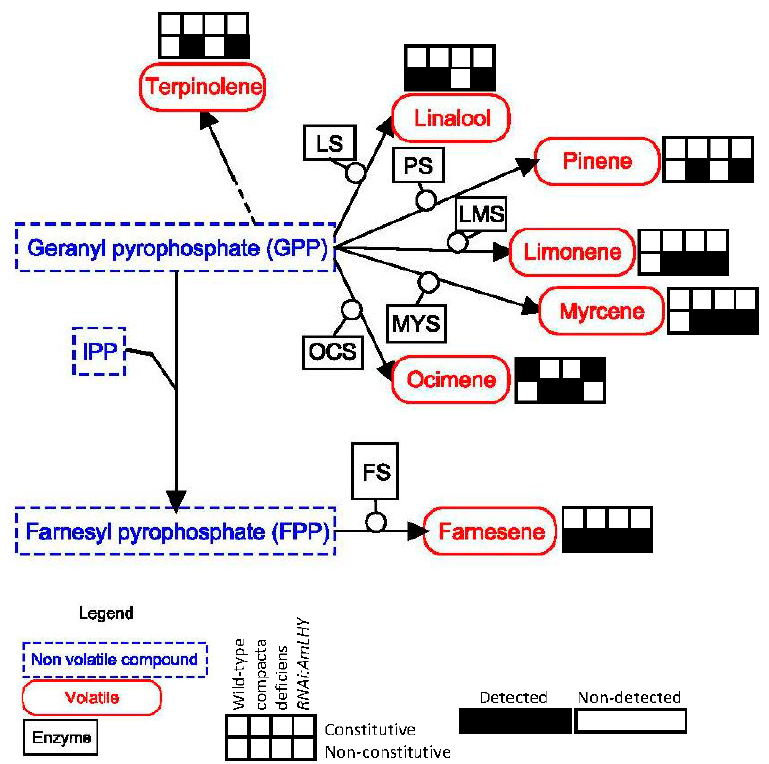
Figure 7. Terpenoids schematic pathway. Representations are like in Figure 7. LS: linalool